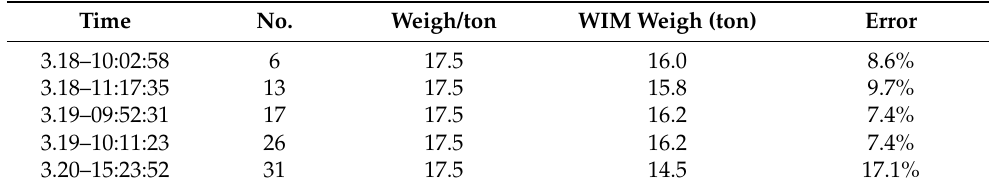
Table 2. Comparison of the data of vehicles passing through the weighing area in the state of first deceleration and then acceleration (5 vehicles data, for